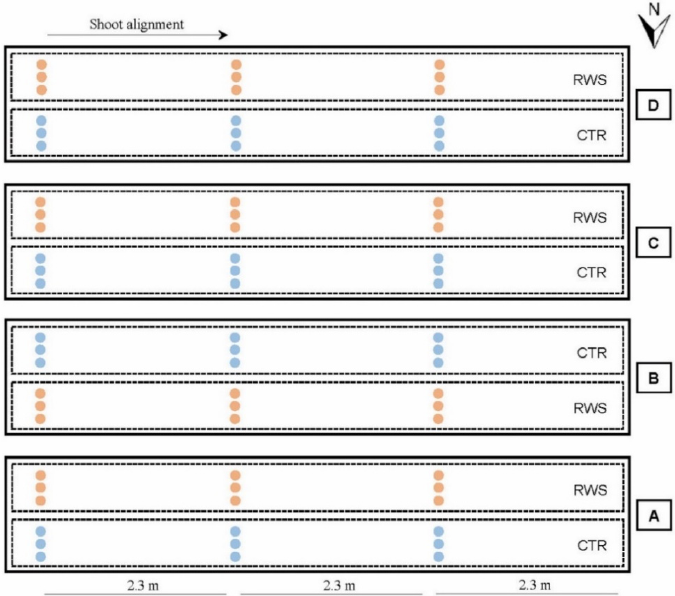
Figure 1. Structure of the experimental setup for the greenhouse cultivation of pickling cucumbers in 2015. Each plot (A–D) was divided into two subplots (CTR and RWS) for the application of two different irrigation regimes. Each subplot consisted of nine plants; fully watered plants are marked by blue circles, while reduced watered plants are marked by orange circles. CTR: control, full water supply (100%), RWS: reduced water supply (60%).